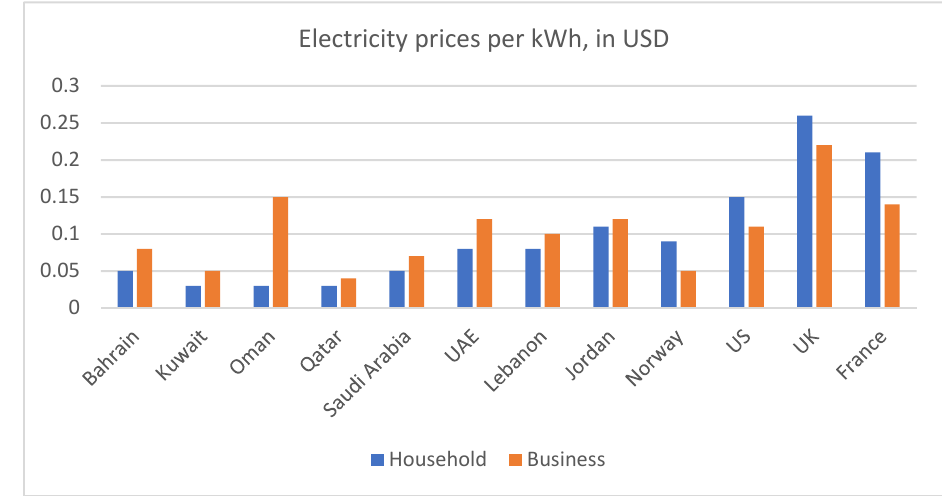
Figure 3. Electricity prices in the Gulf and selected countries, March 2020 [112].